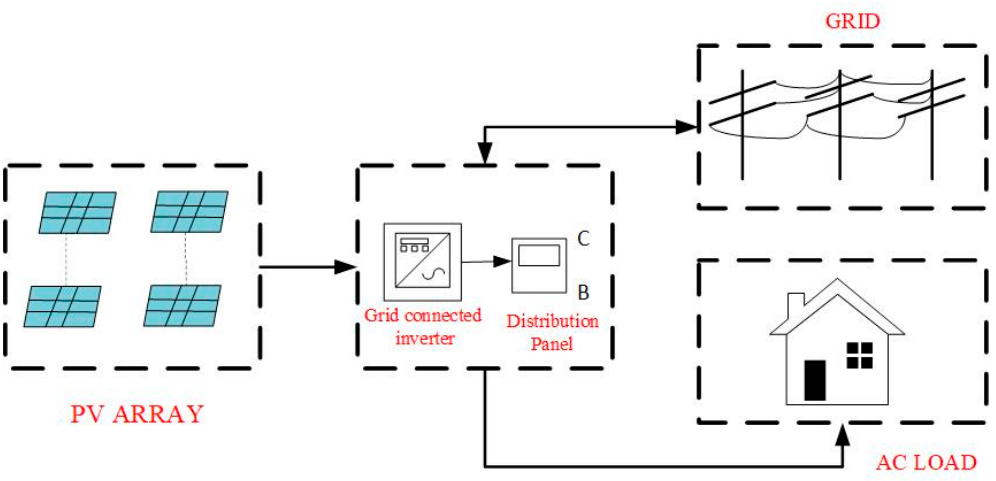
Figure 1. Grid-Connected Photovoltaic (PV) System.